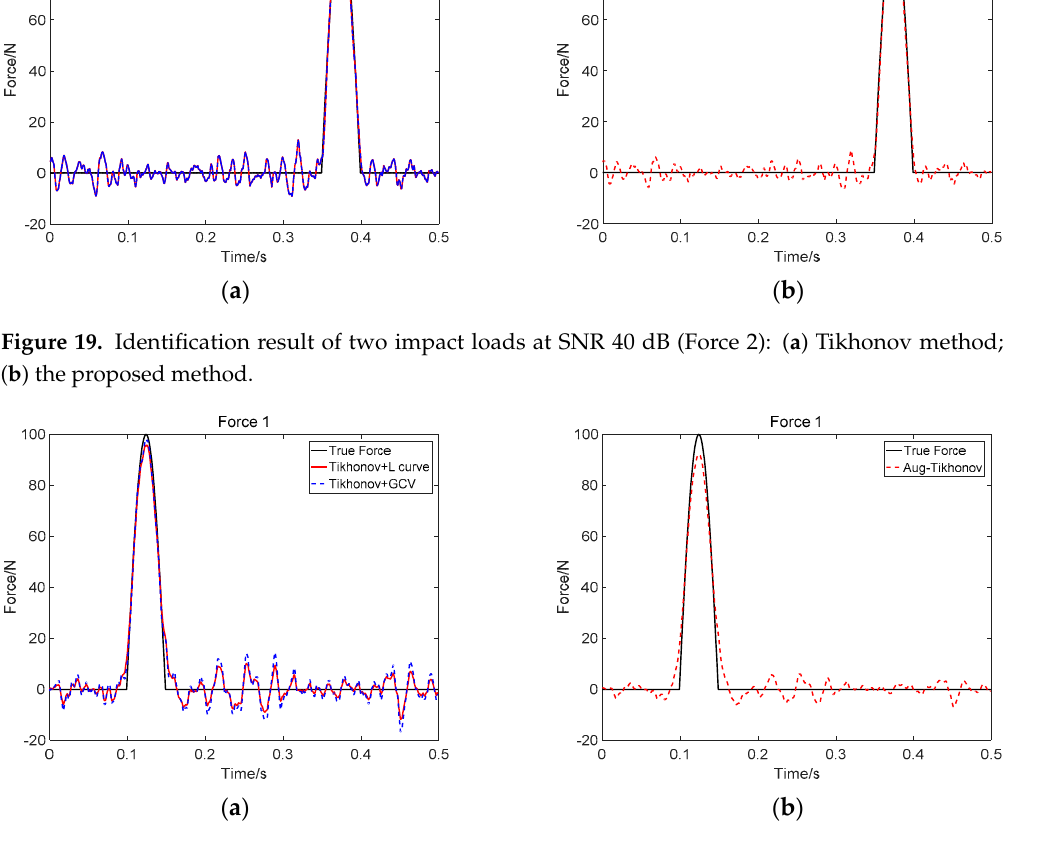
Figure 20. Identification result of two impact loads at SNR 30 dB (Force 1): ( a ) Tikhonov method; ( b ) the proposed method.